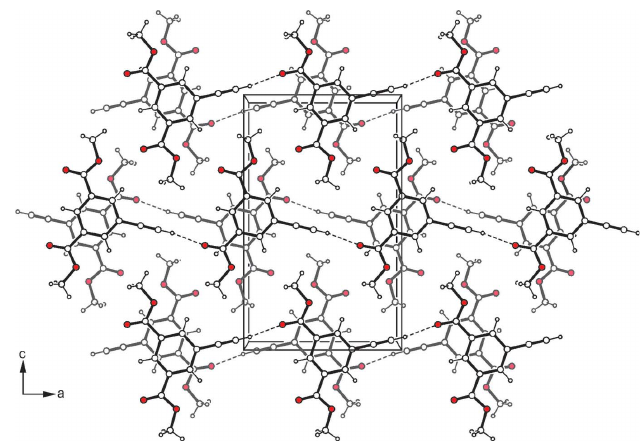
Figure 2 Packing diagram of compound (I) viewed down the a axis. Dashed lines represent hydrogen-bonding interactions.